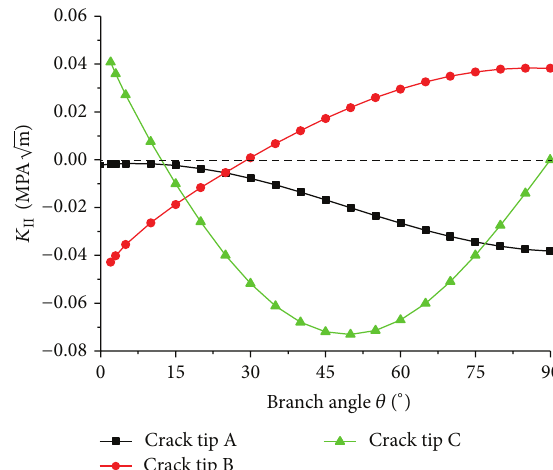
Figure 7: Curves of SIF 𝐾